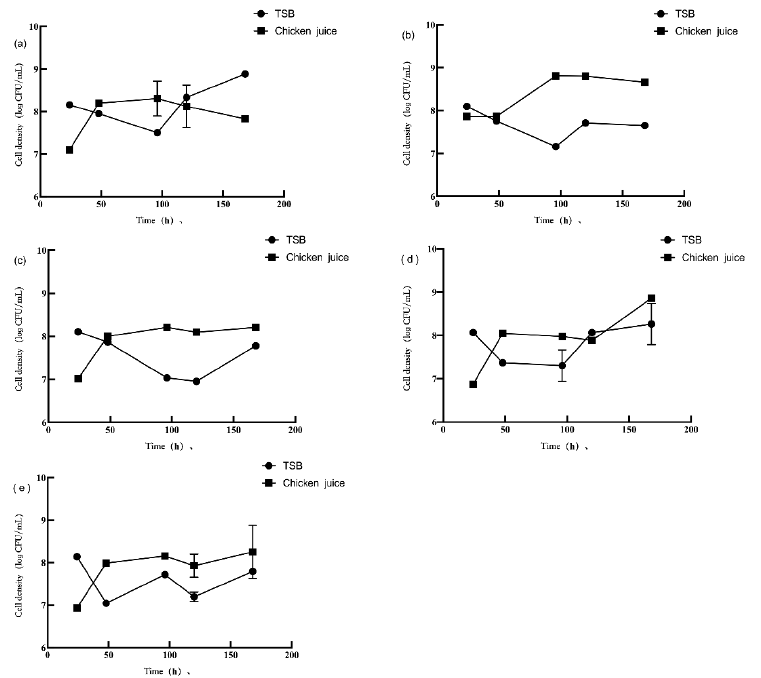
Figure 4. The planktonic population of P. aeruginosa (a–e) in different incubation conditions. Note: The mono-species suspension of P. aeruginosa biofilms with the initial inoculum concentration of 3 log CFU/mL ( a ) and 4 log CFU/mL ( b ); the dual-species suspension of L. monocytogenes and P. ae- ruginosa biofilms with the ratio 1:1 ( c ); 1:10 ( d ); and 10:1 ( e ). In the chicken juice, compared to the mono-species suspension, the planktonic L. monocytogenes concentration in the dual-species suspension (1:1) was significantly re- duced by 5.47 and 4.84 log CFU/mL ( p < 0.05) after 48 h and 96 h, respectively, but was increased by 4.81 log CFU/mL ( p < 0.05) after 120 h. Compared to the mono-species sus- 1:10 significantly decreased by 5.49 and 4.65 log CFU/mL at 24 h and 120 h, respectively, but increased by 5.78 log CFU/mL at 96 h ( p < 0.05). In the dual-species suspension (10:1), L. monocytogenes significantly increased by 4.75–5.98 log CFU/mL ( p < 0.05) at any time point of incubation compared to the mono-species suspension. The concentration of planktonic P. aeruginosa in the dual-species suspension (1:1, 1:10, and 10:1) was signifi- cantly inhibited by L. monocytogenes ( p < 0.05) after 24 h and 120 h of incubation ( p < 0.05). Compared to the mono-species suspension, the planktonic P. aeruginosa concentration decreased by 6.33, 7.82, and 6.60 log CFU/mL in the dual-species suspension (1:1, 1:10, and 10:1) after 24 h of incubation, respectively, and decreased by 6.90, 8.75, and 7.89 log CFU/mL after 120 h of incubation, respectively. Compared with the mono-species sus- pension, the planktonic P. aeruginosa concentration in the dual-species suspension (1:1 and 10:1) decreased by 7.76 and 7.78 log CFU/mL after 48 h of incubation, respectively. Compared with mono-species suspension, after 48 h of incubation, the concentration of planktonic P. aeruginosa in the dual-species suspension (1:10) significantly increased by 7.59 log CFU/mL. However, with a further extension of the incubation time to 96 h, the P. aeruginosa concentration decreased by 8.74 log CFU/mL.